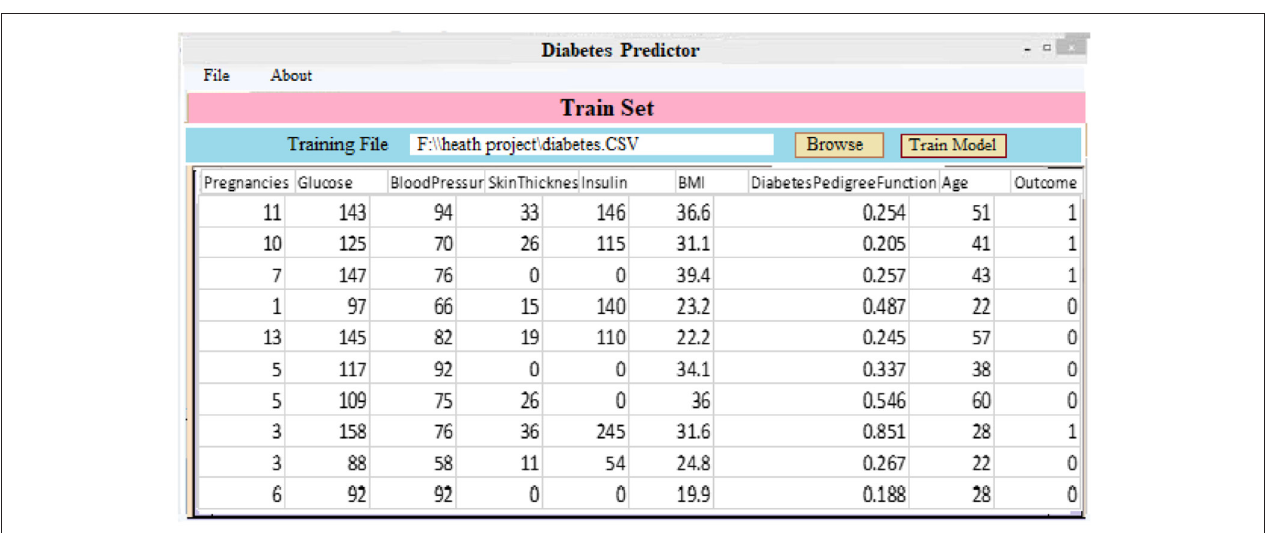
FIGURE 6 | Create a model screen by loading training